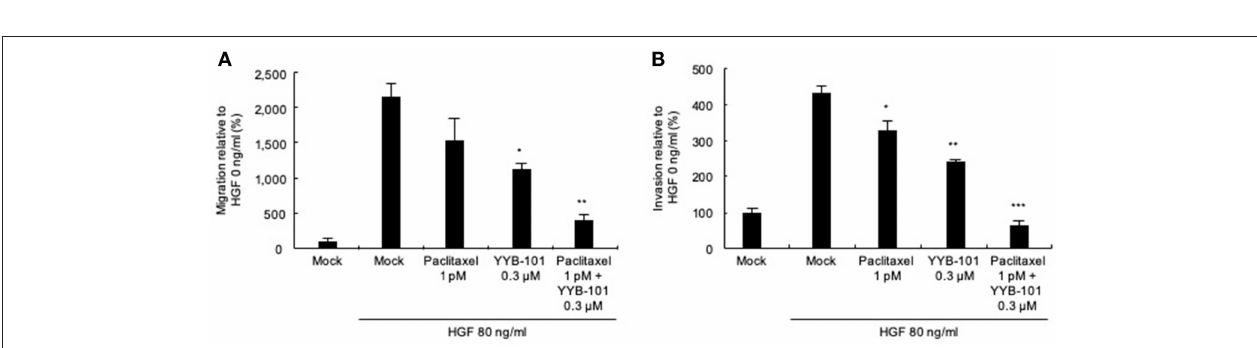
FIGURE 4 | Efficacy of co-treatment with YYB-101 and paclitaxel on invasion of ovarian cancer cells. (A) A2780/luc (3 × 10 5 ) cells were seeded in upper chamber. In the lower chamber, 1 pM paclitaxel, 0.3 µ M YYB-101, or paclitaxel plus YYB-101 was added to the serum free culture media with 80ng/mL hepatocyte growth factor (HGF). After 48h culture, migrated cells were observed using light microscopy. (B) A2780/luc (2 × 10 5 ) cells were seeded onto Matrigel-coated upper chambers. In the lower chamber, 1 pM paclitaxel, 0.3 µ M YYB-101, or paclitaxel plus YYB-101 was added to serum free culture medium with 80ng/mL HGF. After 72h culture, migrated cells were observed using light microscopy. * p < 0.05, ** p < 0.01, and *** p < 0.001 vs. control, one-way ANOVA, followed by Tukey’s multiple comparison